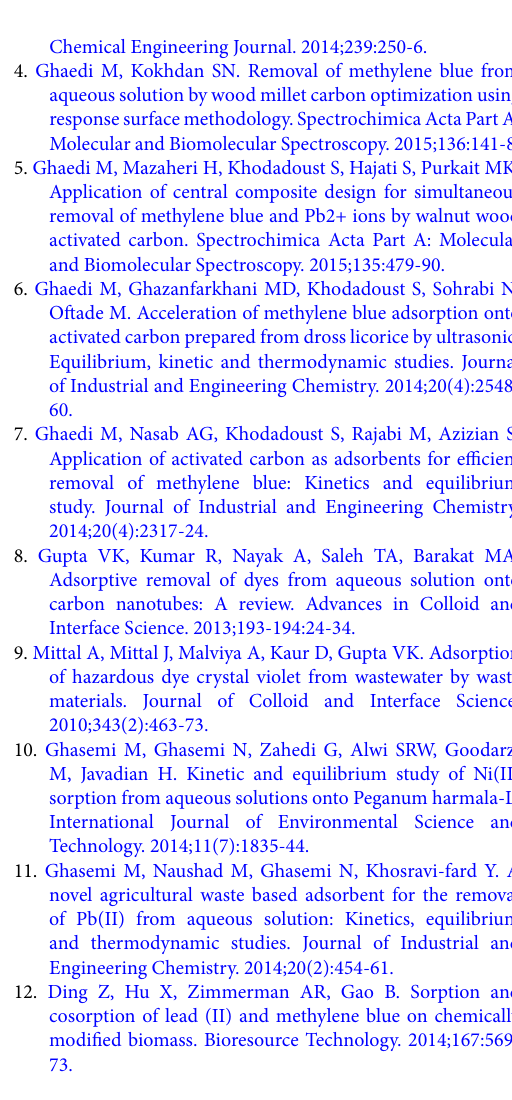
Fig. 9. Adsorption-desorption